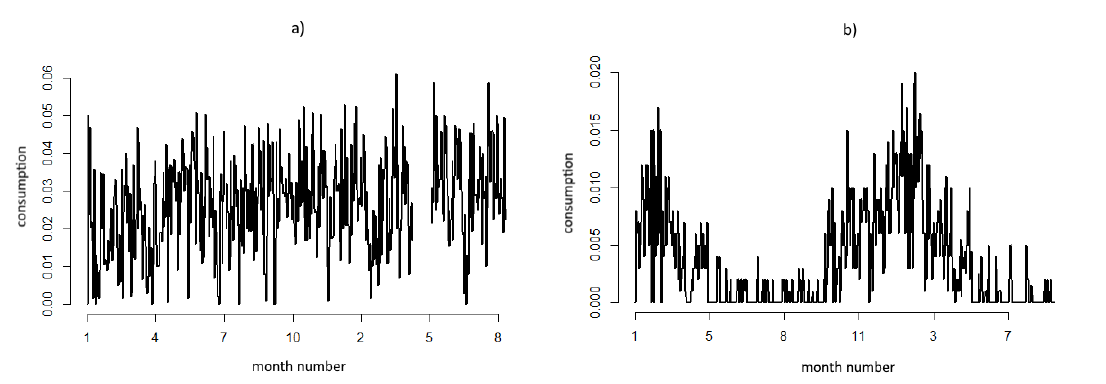
Figure 5. Consumption values (fraction of the tank’s capacity) within months—non-temperature-dependent characteristic ( a ); temperature-dependent characteristic ( b ).